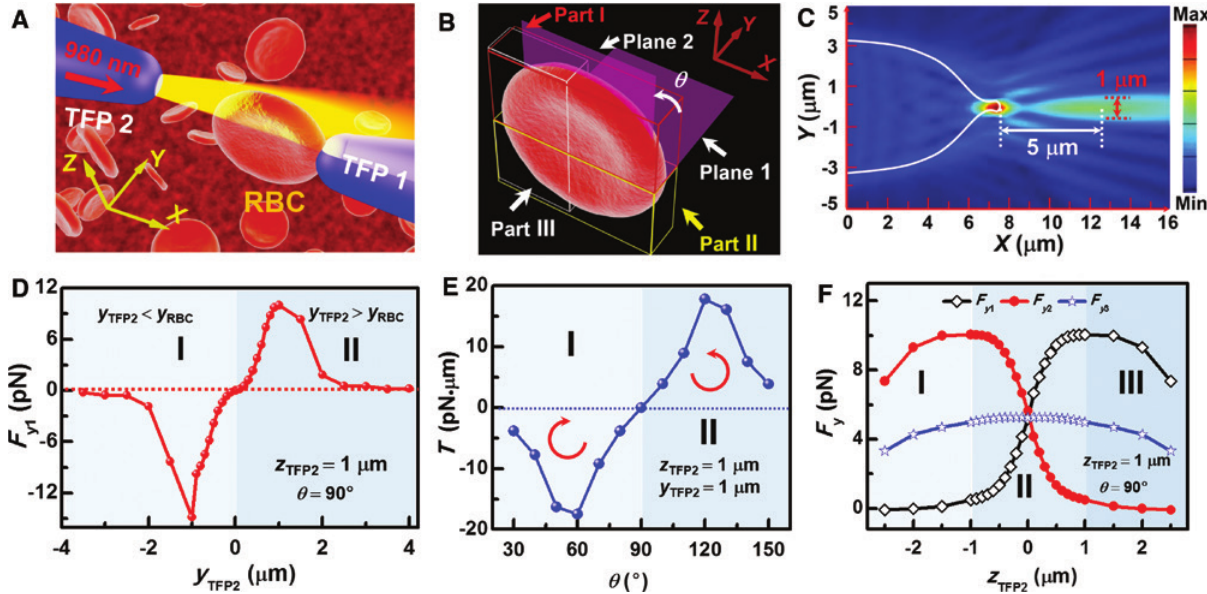
Figure 1: (A) Schematic of RBC rotation around the x axis. (B) Schematic of the RBC profile. (C) Simulated E -field distribution of light from TFP 2 tip. (D) Optical force F Red arrows indicate the cell rotation direction. (F) Optical forces F μ m and θ = 90 °